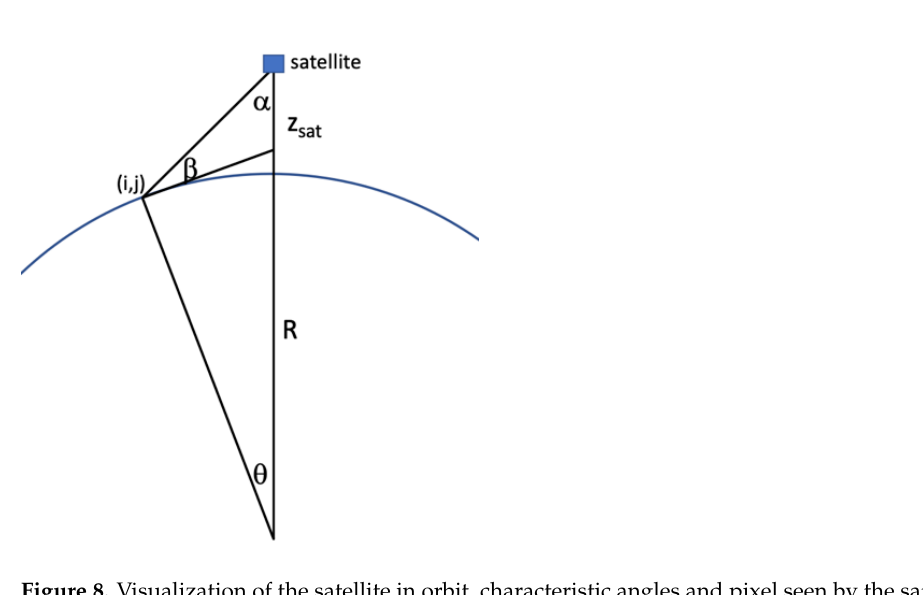
Figure 8. Visualization of the satellite in orbit, characteristic angles and pixel seen by the